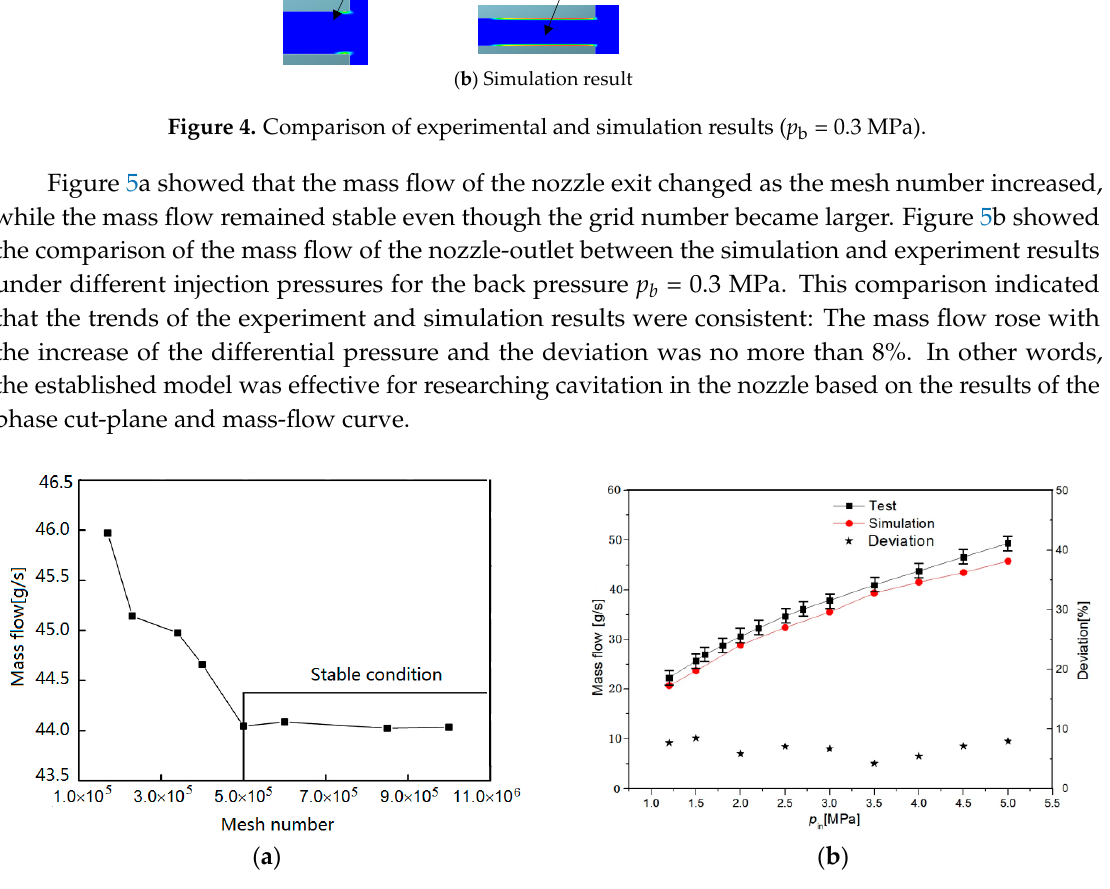
Figure 5. Comparison of experimental data and simulation result. ( a ) Grid independency, ( b ) Mass flow